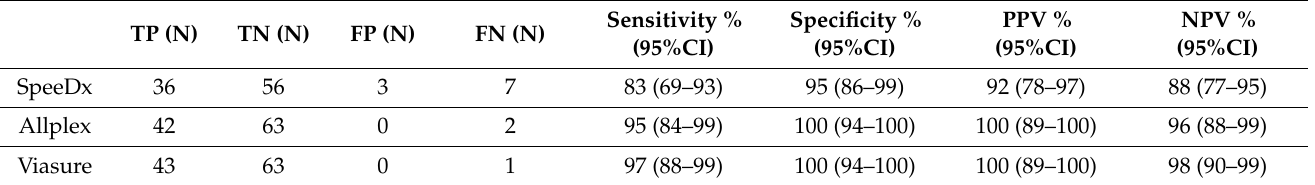
Table 3. Clinical validation results (95% confidence interval) after the study of the discordant